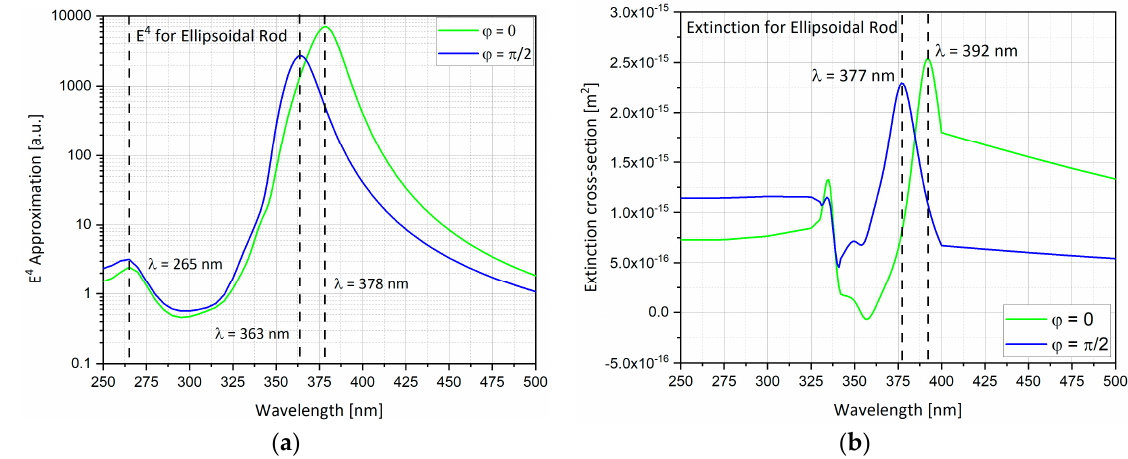
Figure 10. Ellipsoidal rod results while changing the polar angle θ in a wavelengths range of λ = 250–500 nm. ( a ) E 4 approximation; ( b ) extinction cross-section.